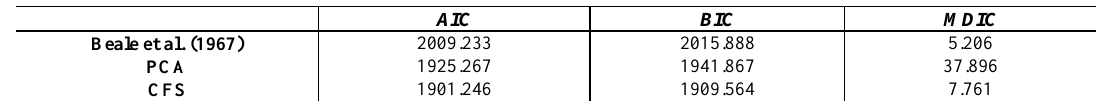
Table 4. Model selection